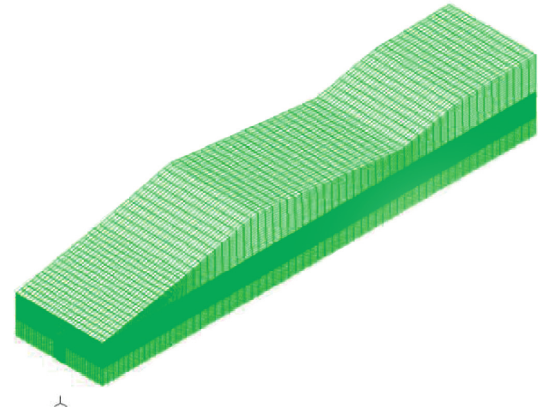
Figure 11: 3D mesh of the numerical